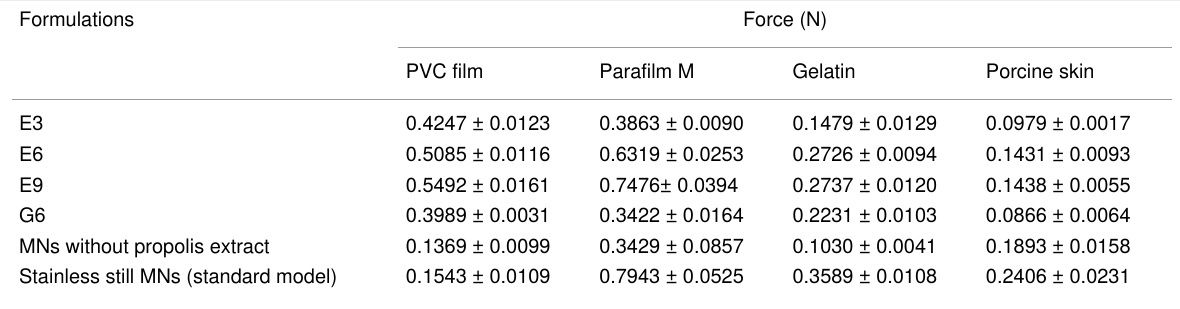
Table 4: Compression force (N) of the selected MN formulations applied on different surfaces (PVC film, Parafilm M, gelatin and porcine skin). Each analysis was performed, at least, in triplicate.